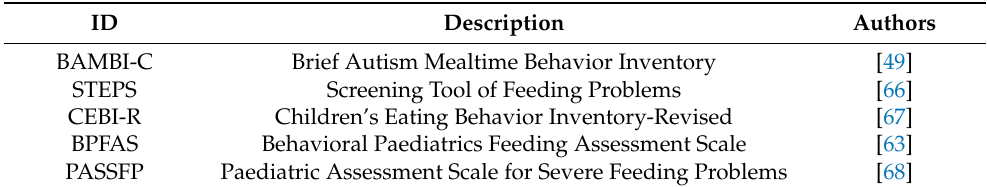
Table 1. Descriptions of some main questionnaires regarding feeding behaviors.